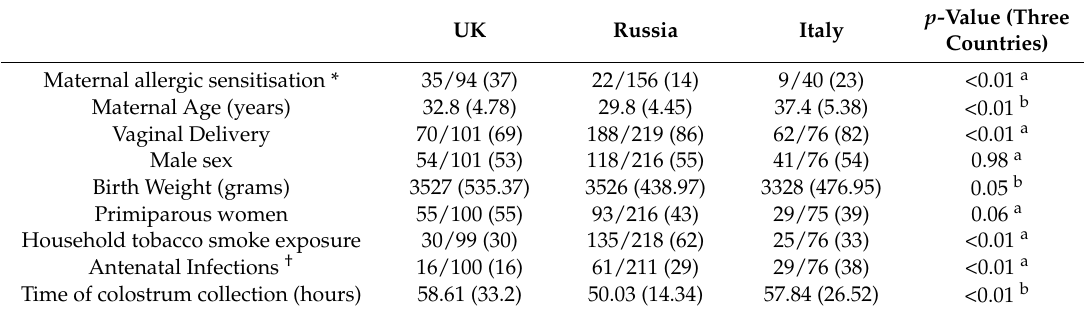
Table 1. Characteristics of study participants.